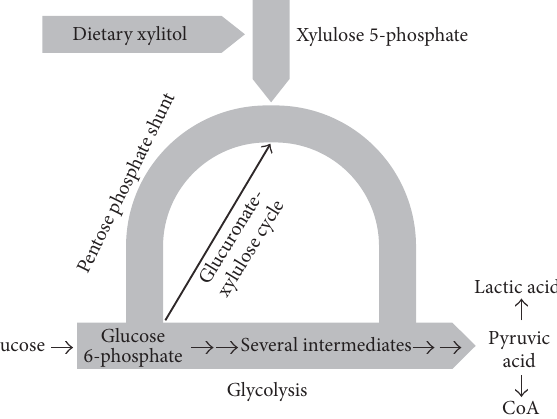
Figure 1: Relationship between the metabolism of xylitol and glycolysis in humans. The scheme describes the metabolism of dietary xylitol in broad outline only. The body receives energy from glycolysis (the thick horizontal arrow). The first intermediate of glycolysis is glucose 6-phosphate which forms an important link between glycolysis and another metabolic pathway, called the pentose phosphate shunt, or pentose phosphate cycle (curved arrow).Thethinnerblackarrowrepresentstheglucuronate-xylulose cycle of Touster. The differences in the thickness of the arrows reflect the relative portion of these three pathways in the overall metabolism. Although the significance of the Touster cycle is minor from the energetic point of view, it is nevertheless absolutely necessary for body functions. Pyruvic acid which may be regarded as the end product of glycolysis can be further metabolized in two ways: reduction to lactic acid under conditions of limited oxygen supply, or becoming a part of coenzyme A when the oxygen supply is sufficient. The scheme shows how xylitol can contribute to the overall energy metabolism of the body. The original scheme of B¨assler [67] was modified and completed by the present